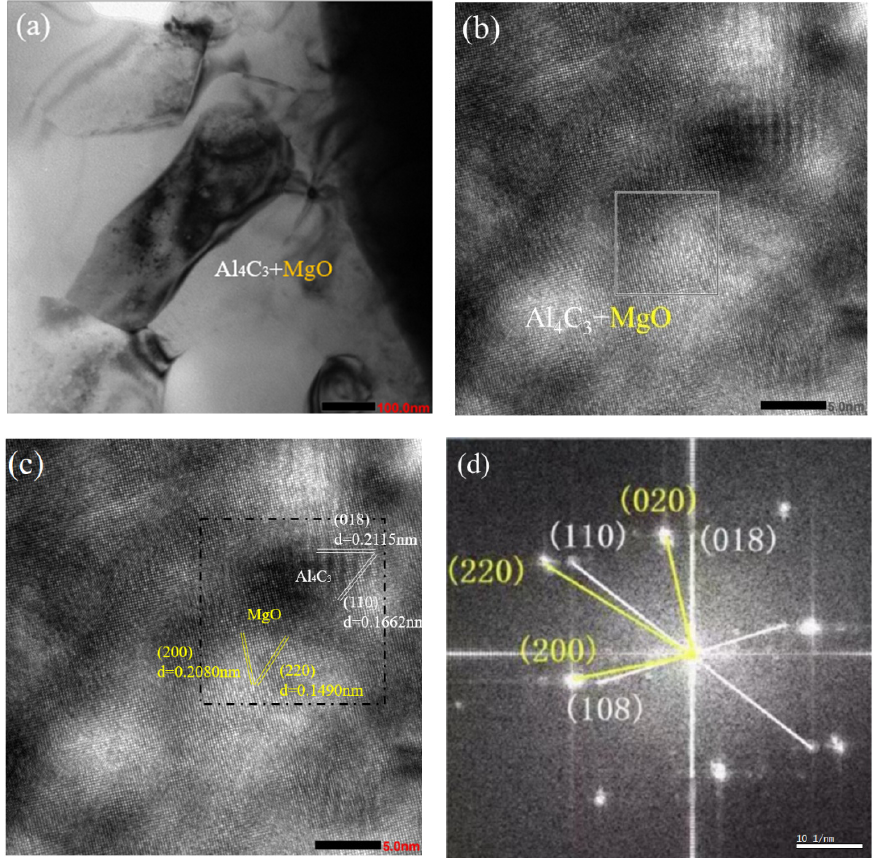
Figure 9. SiC p /AZ91: TEM microstructure near the interface of composites. ( a ) morphology of the matrix structure, ( b ) HREM image of the matrix structure ( c ) Calibrate HREM image ( d ) filtration image of ( c ).